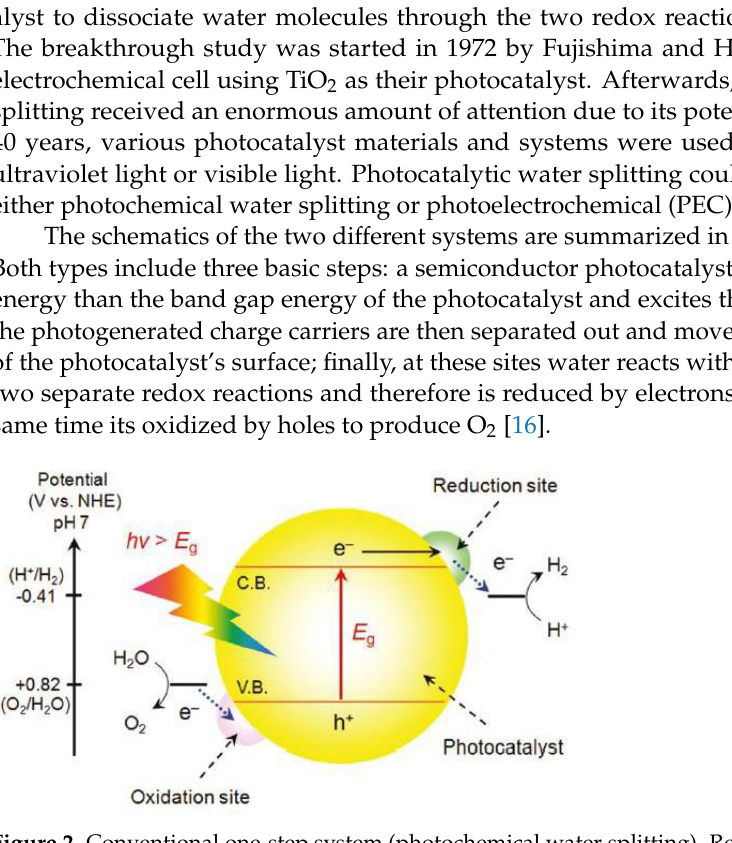
Figure 2. Conventional one-step system (photochemical water splitting). Reprinted with permission from [16]. Copyright 2022 American Chemical Society.